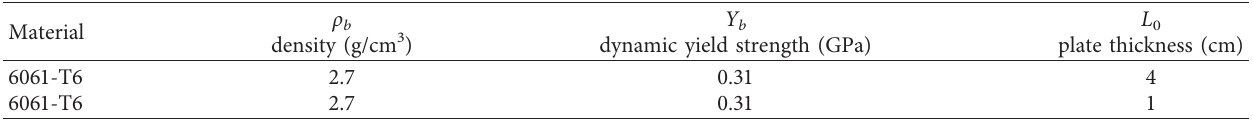
Table 5: Parameters of the material for Al backplate models [9].